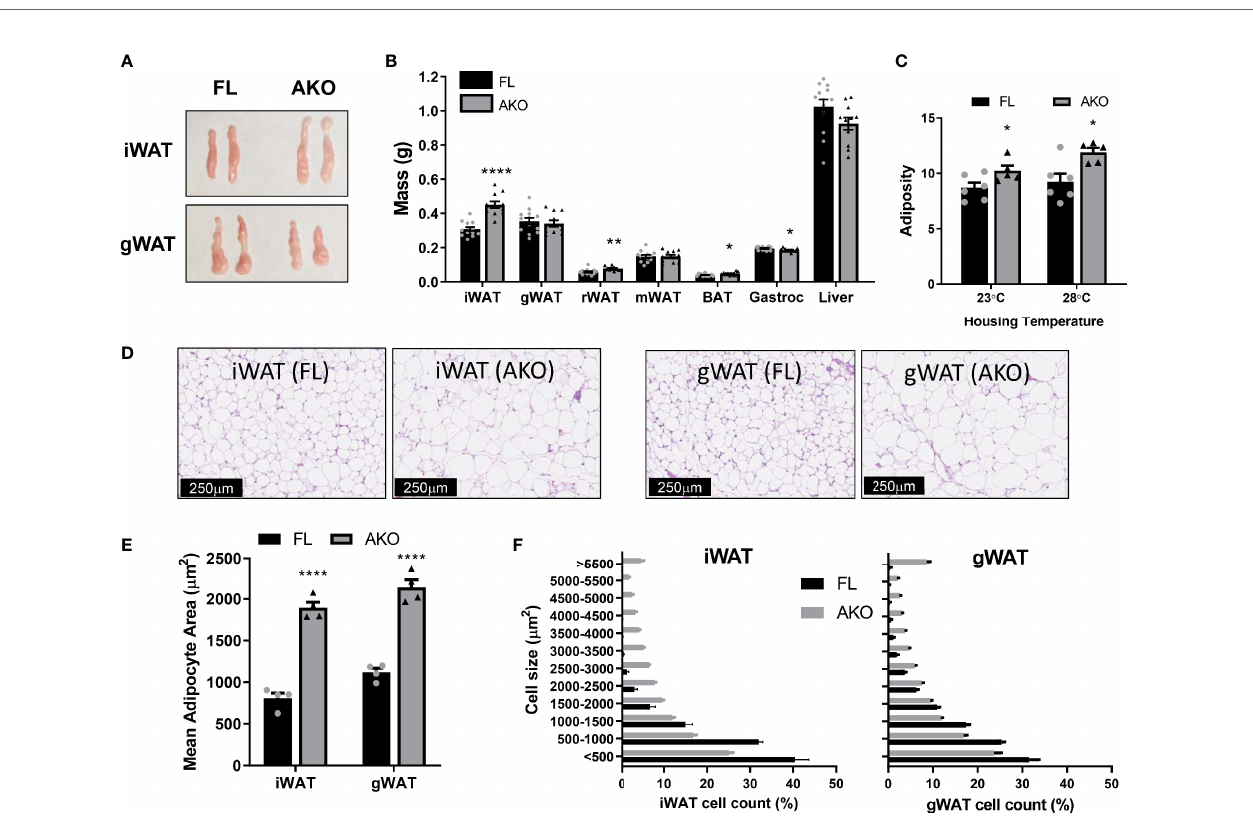
FIGURE 2 | Female STAT5 AKO mice have increased subcutaneous adiposity when fed chow diet. Female STAT5 AKO (AKO) and fl oxed (FL) littermate control mice were weaned onto regular chow diet (13% kcal from fat). (A) Representative images of inguinal and gonadal white adipose tissue depots (iWAT and gWAT) from fi ve- month-old mice. (B) Weights of white adipose tissue depots (iWAT, gWAT, retroperitoneal - rWAT, mesenteric - mWAT), brown adipose tissue (BAT), gastrocnemius skeletal muscle (Gastroc), and liver collected from 10-week-old mice (n = 11-13). (C) Mice (n = 5-6 per group) were housed at different temperatures beginning at weaning (3 weeks of age). Body composition was measured at 9 weeks of age, adiposity was calculated as fat mass divided by total body weight for each animal. (D) Representative images of H&E-stained inguinal and gonadal white adipose tissue depots (iWAT and gWAT) from fi ve-month-old mice. Quanti fi cation of